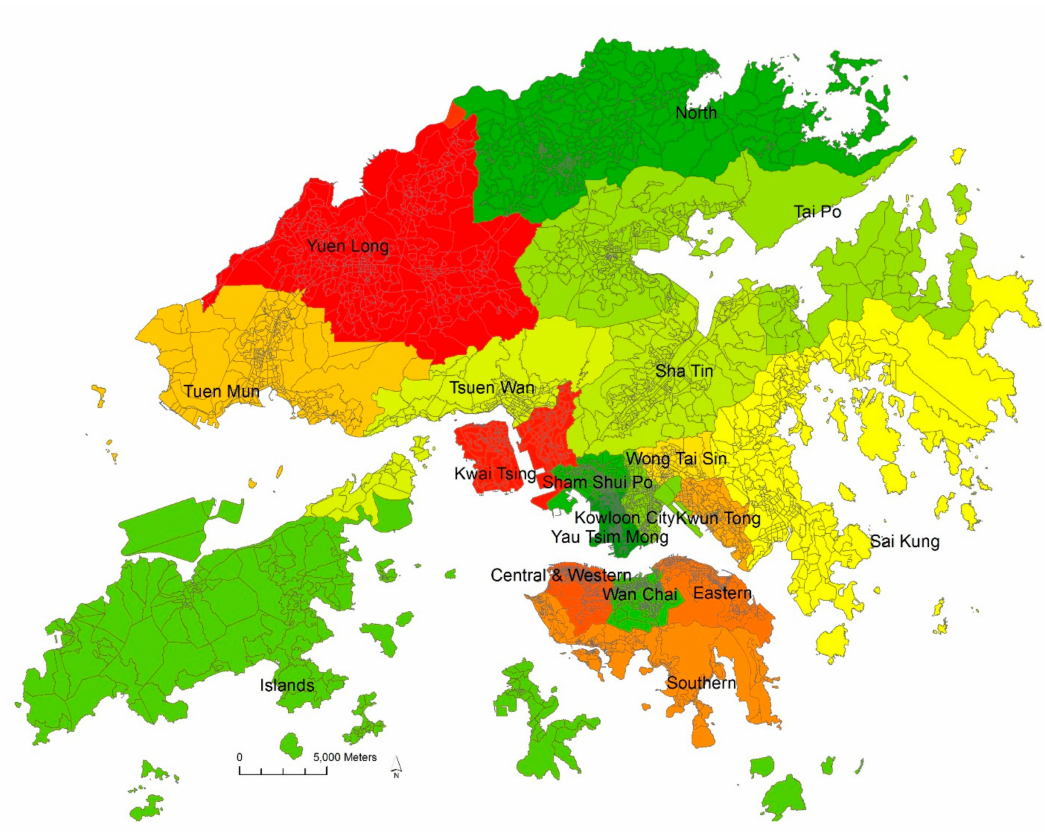
Figure 1. The 18 districts (shown in different colors with district names) and 4768 street blocks (shown as grey lines) in the Hong Kong